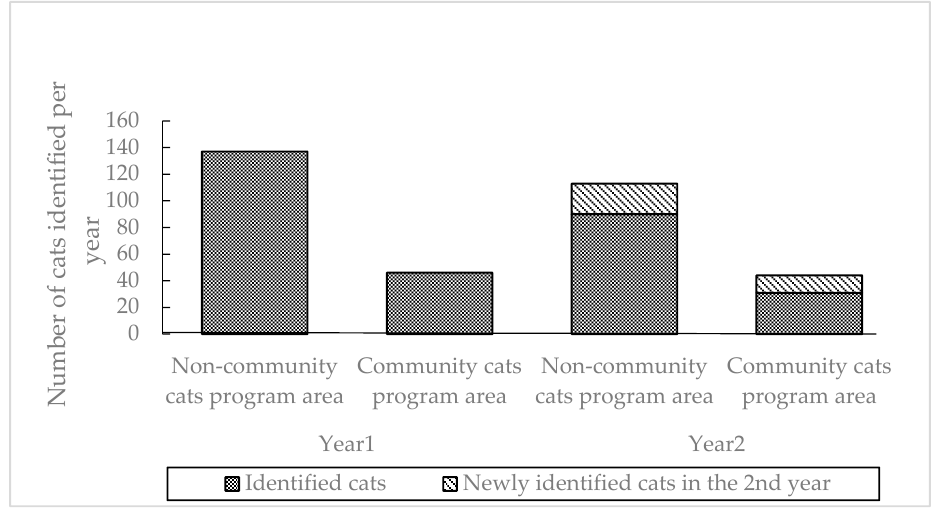
Figure 2. Yearly changes in the total number of cats identified in areas with and without community cats programs. Dark gray columns show the cats observed in Year 1 and light gray parts show newly observed cats in Year 2.